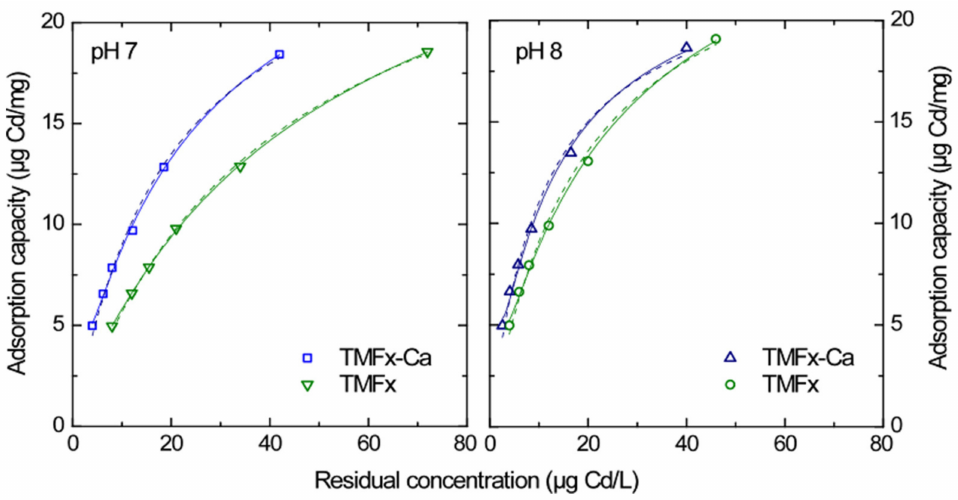
Figure 5. Cd adsorption isotherms in NSF water matrix and for pH values 7 and 8. Solid and dashed lines represent the Freundlich and Langmuir fittings, respectively. Table 2. Freundlich and Langmuir fitting parameters for the Cd adsorption isotherm data. Q 5 Freundlich ( µ g Cd / mg) Adsorbent pH